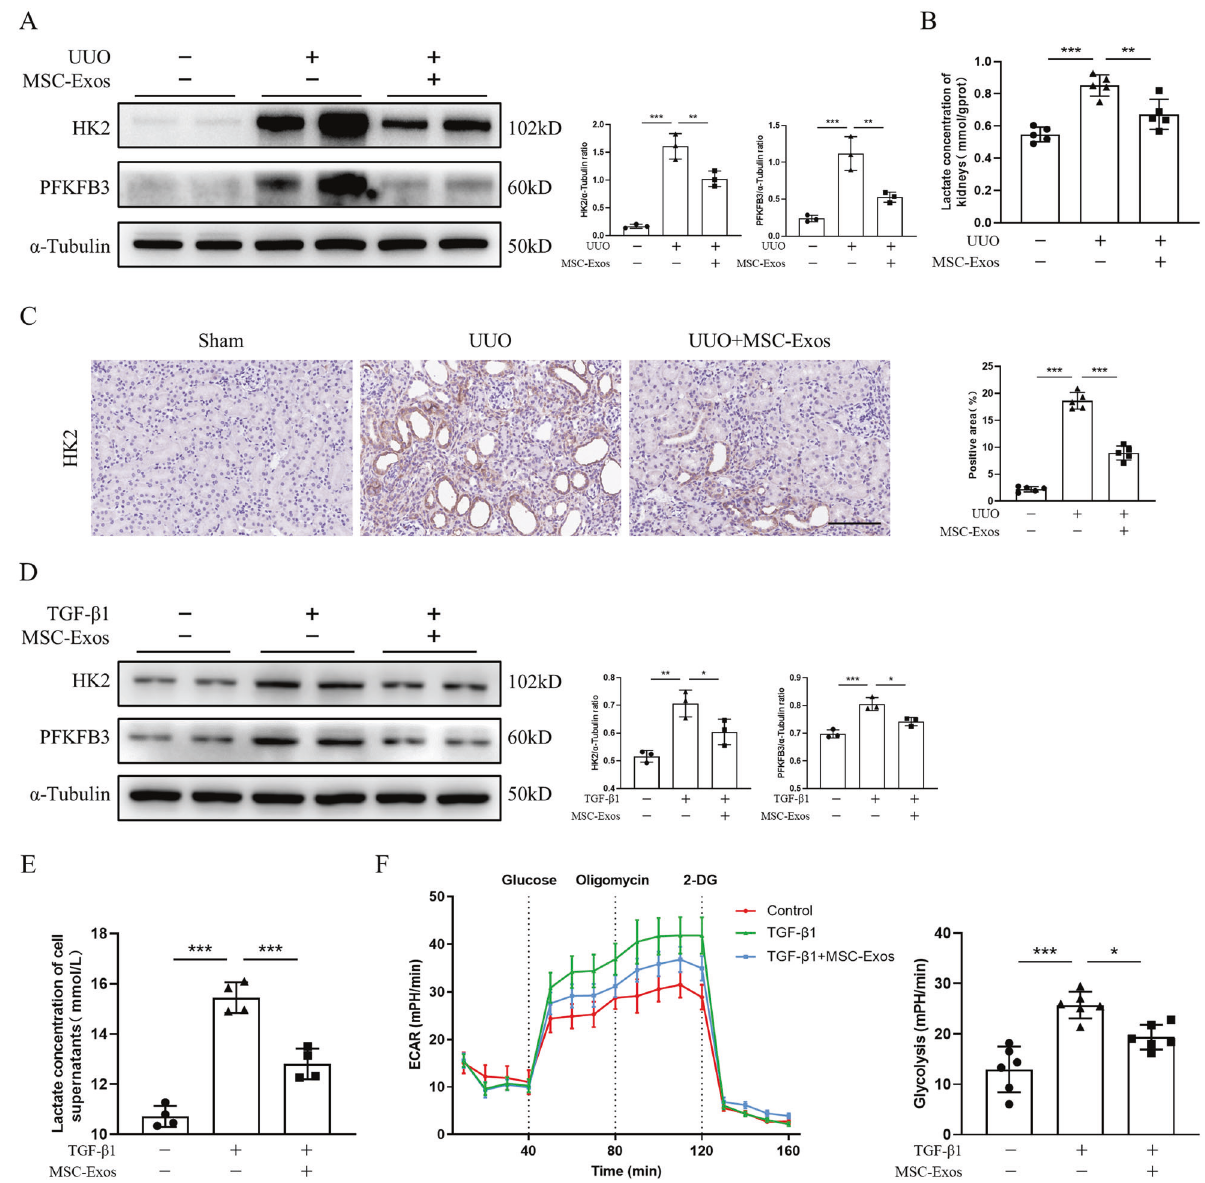
Fig. 3 MSC-Exos attenuate glycolysis in tubular epithelial cells. MSC-Exos (100 µg) or PBS was administered intravenously on Day 0 after UUO induction. Kidneys were isolated from sham, UUO and MSC-Exo-treated mice on Day 7. TCMK-1 cells were incubated with TGF- β 1 with or without MSC-Exos (20 µg). Cells and cell supernatants were collected at 48 h. A The expression of HK2 and PFKFB3 in renal tissues was measured by western blot analysis ( n = 3 mice per group). B The lactate concentration of kidney tissue homogenates was quanti fi ed by a lactate assay kit ( n = 5 mice per group). C Immunohistochemistry staining of HK2 in kidney tissues ( n = 5 mice per group; scale bar = 100 μ m). Representative images from one experiment out of three are shown. D Protein levels of HK2 and PFKFB3 in TCMK-1 cells were assessed by western blot analysis ( n = 3). E Lactate concentration in the supernatant of TCMK-1 cells was assayed by a lactate assay kit ( n = 4). F Real-time ECAR of PBS-, TGF- β 1-, and MSC-Exo-treated TCMK-1 cells was determined by a Seahorse XF96 Extracellular Flux Analyzer ( n = 6). Data are presented as the mean ± SD from three independent experiments. * p < 0.05, ** p < 0.01 and *** p < 5p inhibitor -Exos group compared to the NC-Exos and miR-21a- supernatants. NC-Exos signi fi cantly decreased the expression of PFKM in TCMK-1 cells treated with TGF- β 1, which was reversed by 5p mimic -Exos group (Fig. 5G). Taken together, these results treatment with miR-21a-5p inhibitor -Exos (Fig. 5D, S4, and S5E). The indicated that MSC-Exos attenuate glycolysis in TECs by inhibiting expression of other glycolysis-related enzymes was also signi fi - PFKM through miR-21a-5p. cantly upregulated by miR-21a-5p inhibitor -Exos, while miR-21a- 5p mimic -Exos further inhibited glycolysis in TCMK-1 cells compared miR-21a-5p is essential for the renoprotective effects of MSC- to the NC-Exo group (Fig. 5E and S5F). Moreover, treatment with Exos miR-21a-5p inhibitor -Exos increased the lactate concentration of To further explore whether miR-21a-5p is involved in MSC-Exo- mediated renoprotective effects in vivo, mice were administered TCMK-1-cell supernatants compared to NC-Exos, whereas miR-21a- 5p mimic -Exos eliminated this effect (Fig. 5F). Consistently, the ECAR of the TCMK-1 cells was signi fi cantly increased in the miR-21a- NC-Exo group, mice treated with miR-21a-5p inhibitor -Exos showed